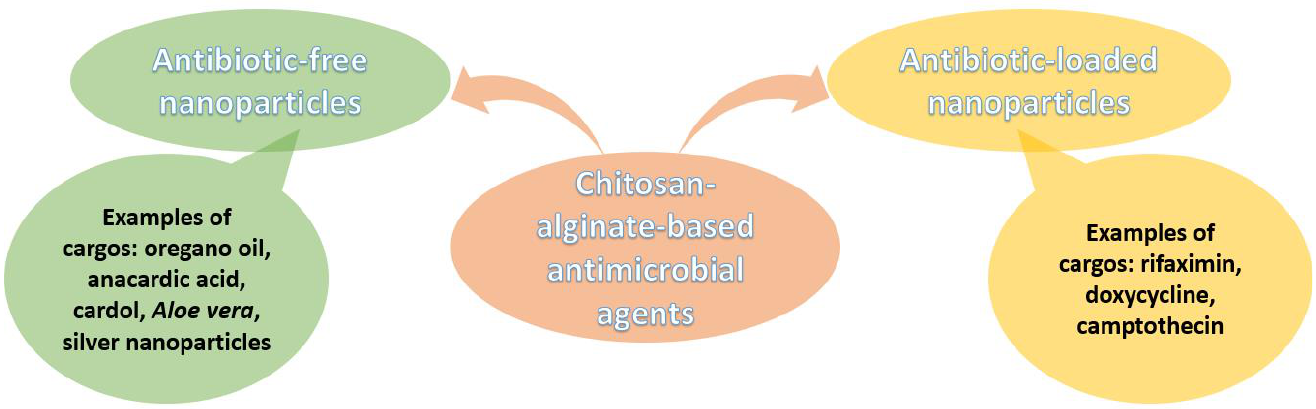
Figure 7. Overview of chitosan-alginate-based antimicrobial nanoformulations.